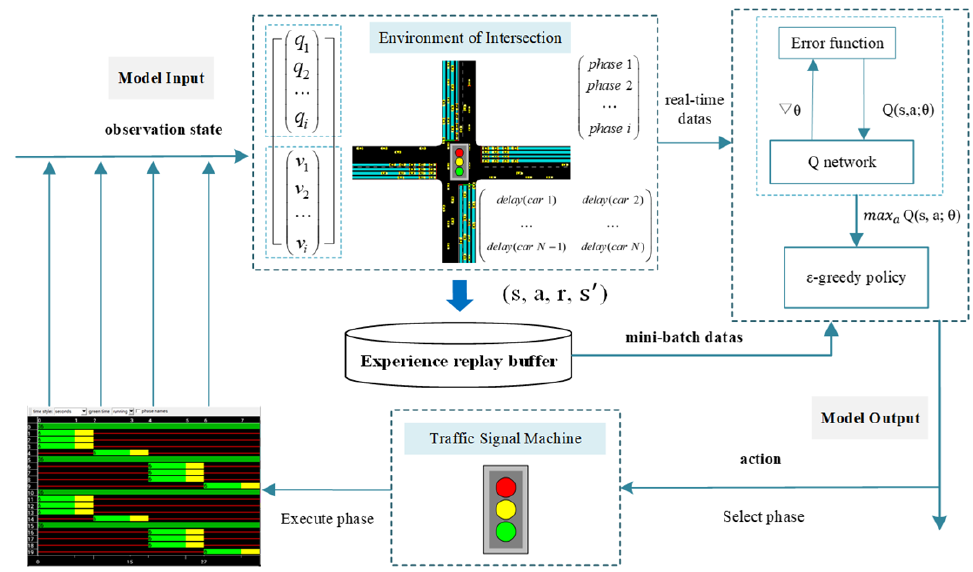
Figure 2. The overall architecture of the DQN